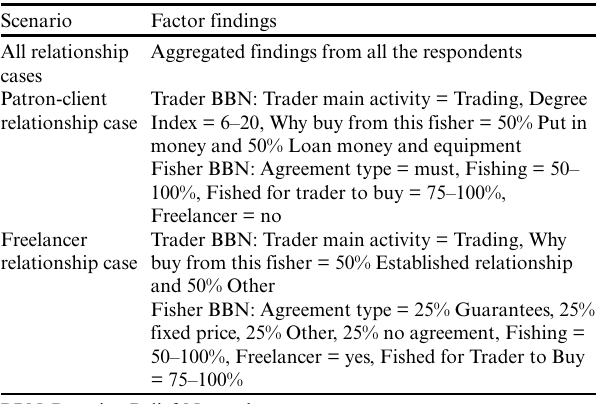
Table 3 . Scenarios and the finding values for the selected factors. Scenario Factor findings All relationship Aggregated findings from all the cases